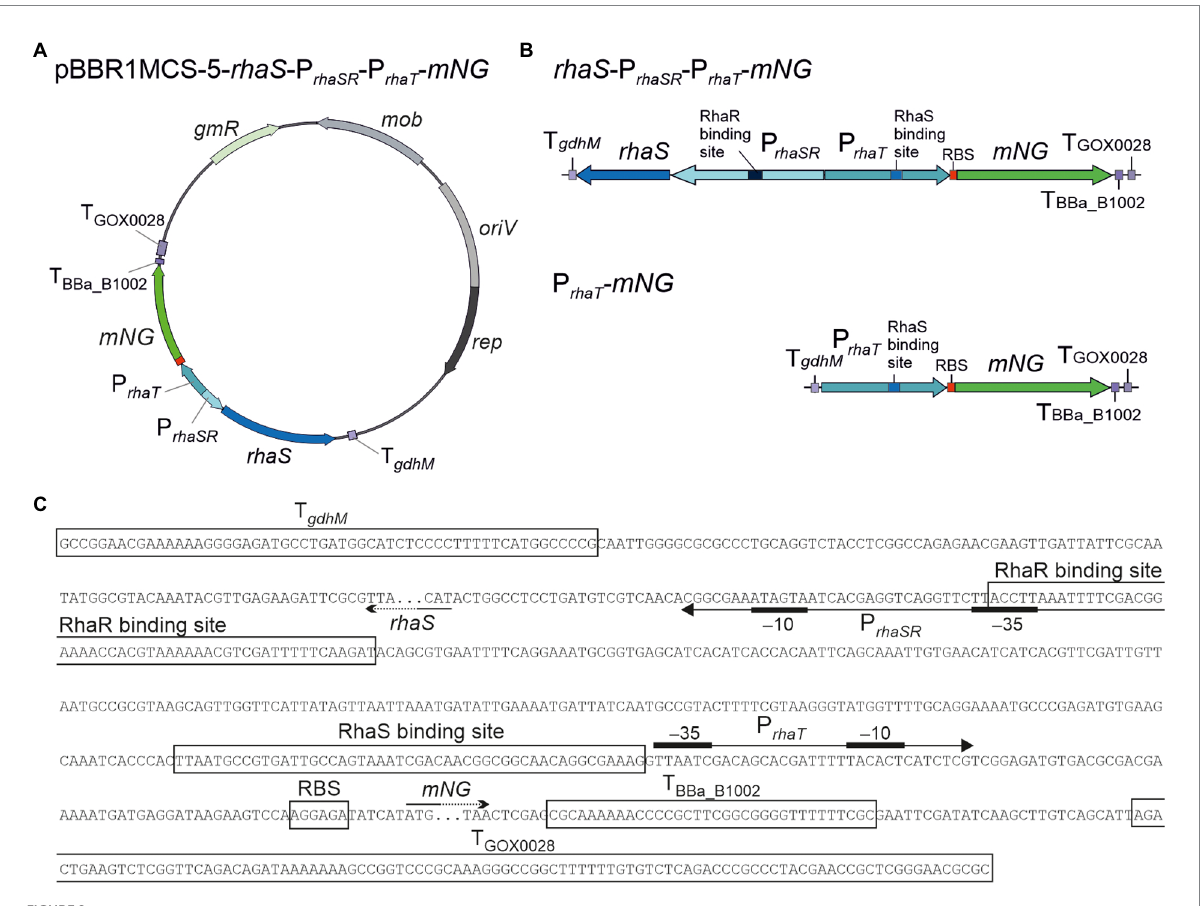
FIGURE 9 Reporter plasmids with P rhaT and sequence details. (A) Map of plasmid pBBR1MCS-5- rhaS -P rhaSR - P rhaT -mNG with the fluorescence reporter gene mNeonGreen ( mNG ) under control of the promoter P rhaT from the l -rhamnose transporter gene rhaT with the adjacent rhaS gene under control of P rhaSR , all flanked by the terminators T gdhM , T BBa_B1002 and T GOX0028 . (B) Schematic illustration of the pBBR1MCS-5 inserts rhaS -P rhaSR - P rhaT - mNG and its variant P rhaT -mNG lacking rhaS -P rhaSR . (C) DNA sequence details with RhaS and RhaR binding sites and terminator sequences downstream from rhaS and mNG . P rhaT promoter elements are given according to Vía et al.